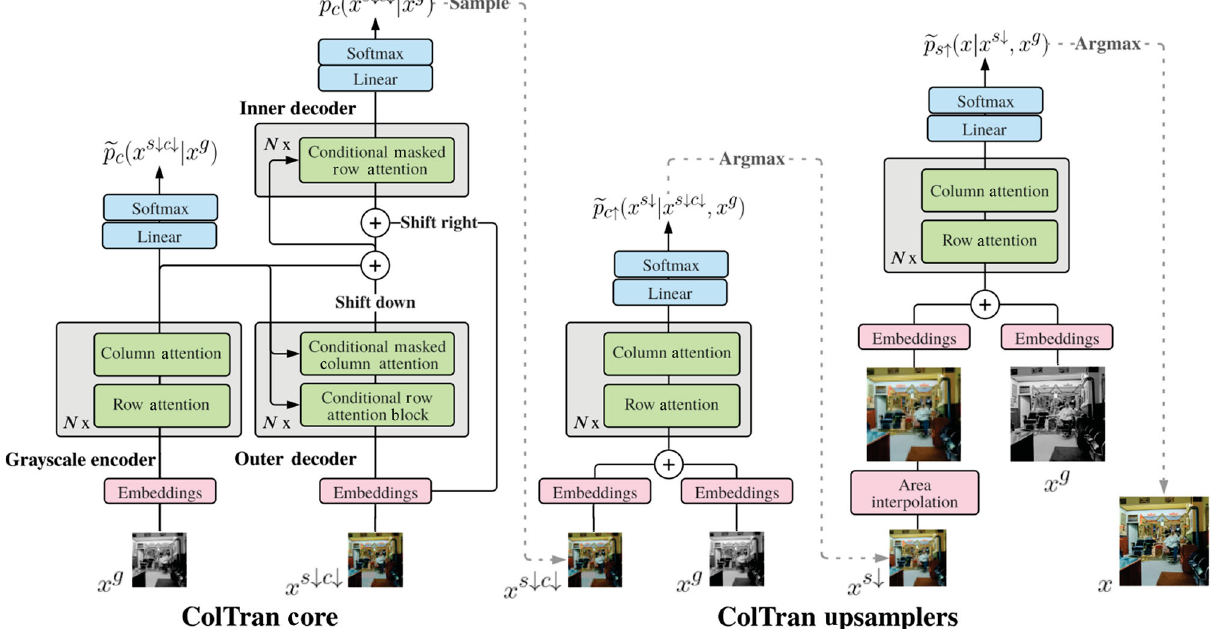
Fig. 19 Overview of colorization transformer. Reproduced with permission from Ref. [30], c (cid:2) The Author(s)